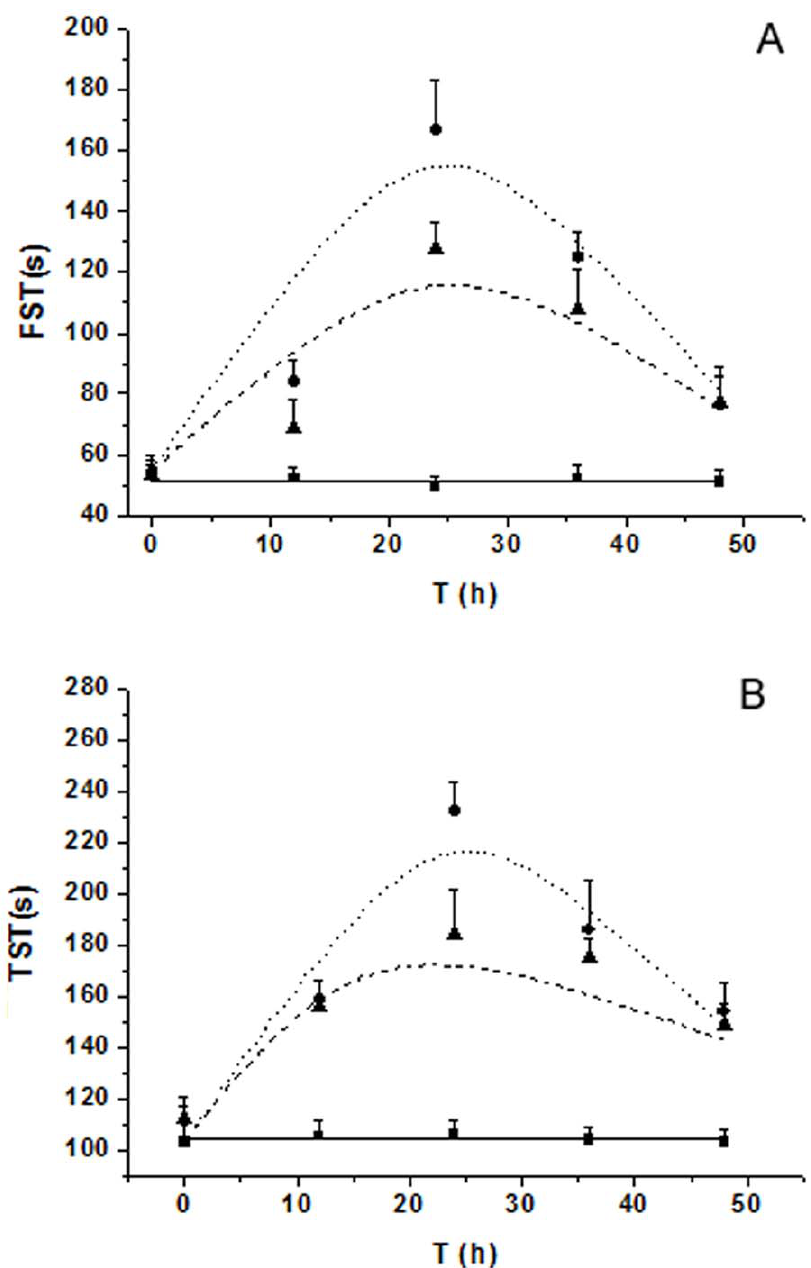
Figure 3. The behavioral profiles of FST (A) and TST (B) after an i.p. LPS (0.8 mg/kg) and AZI treatment (100 mg/kg) in mice. Measured values and model fittings were shown in symbols and lines, respectively. Control mice were shown in closed squares and solid line. The model group was shown in closed circles and dot line. The regulative effect following a single oral dose of AZI was shown in closed triangle with dash line. All observations were reported as Mean 6 SD